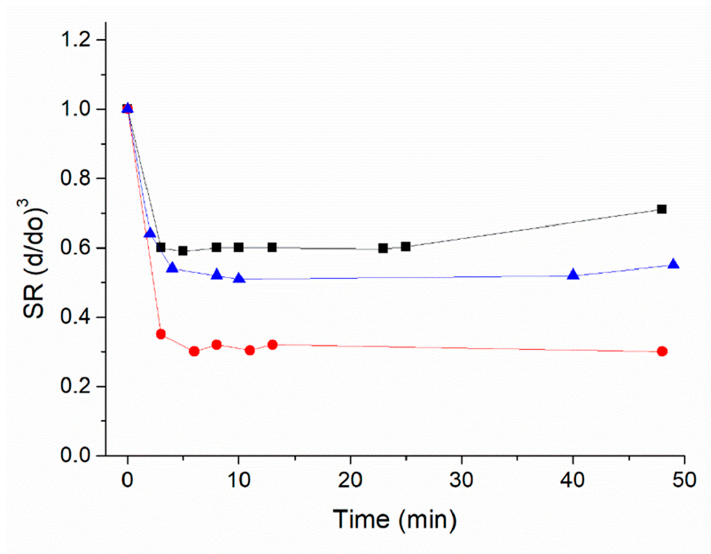
Figure 1. Flexibility of the nanogels monitored as a modification of the hydrodynamic size with the addition of isopropanol to the water suspension. Blue track: isopropanol:water 1:99 v / v ; Black track: isopropanol:water 1:19 v / v ; Red track: isopropanol:water 3:17 v / v . Measurements were in triplicate; StDv < 10%.